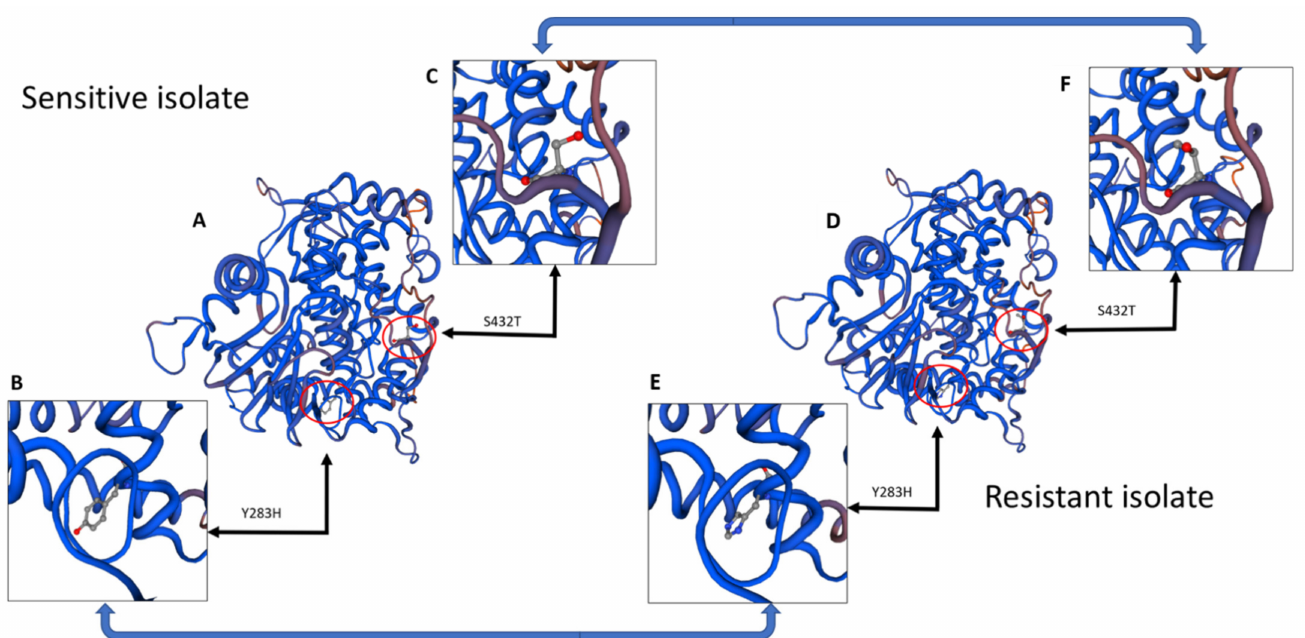
Figure 4. Molecular modeling of CYP51A . ( A ) Molecular model of fungicide-sensitive CYP51A , with red circles highlighting the molecular arrangement of specific amino acids mutated in the resistant version. ( B ) Zoomed-in window at tyrosine 283 to show molecular structure and location. ( C ) Zoomed-in window at serine 432 to show molecular structure and location. ( D ) Molecular model of highly fungicide-resistant CYP51A , with red circles highlighting the molecular arrangement of specific amino acids different from the sensitive version. ( E ) Zoomed-in window of histidine 283 (changed from tyrosine) to show molecular structure and location. ( F ) Zoomed-in window at threonine 432 (changed from serine) to show molecular structure and